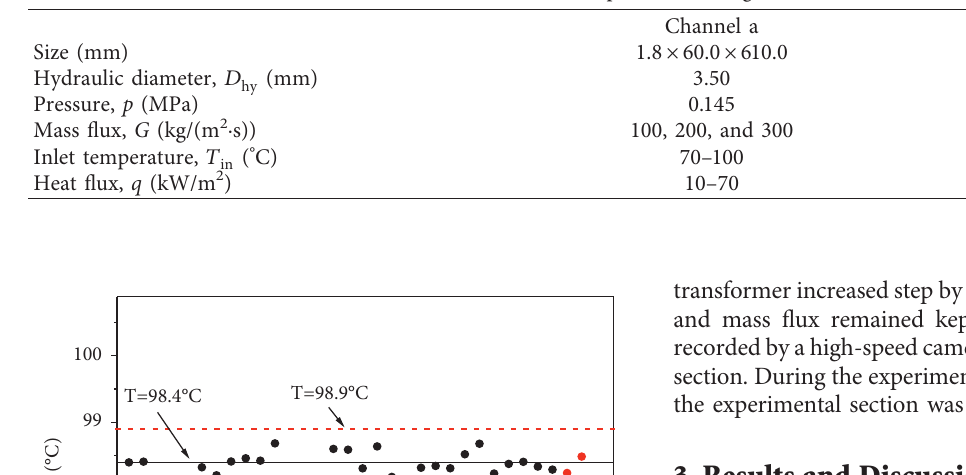
Table 2: Parameters and experimental range of two test sections.